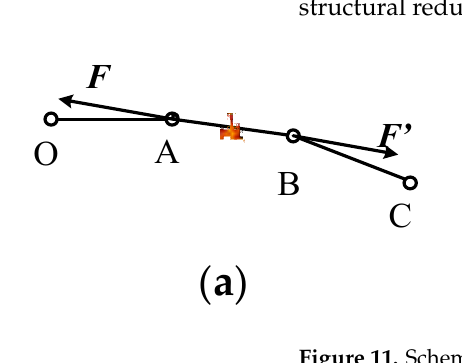
sition of force.